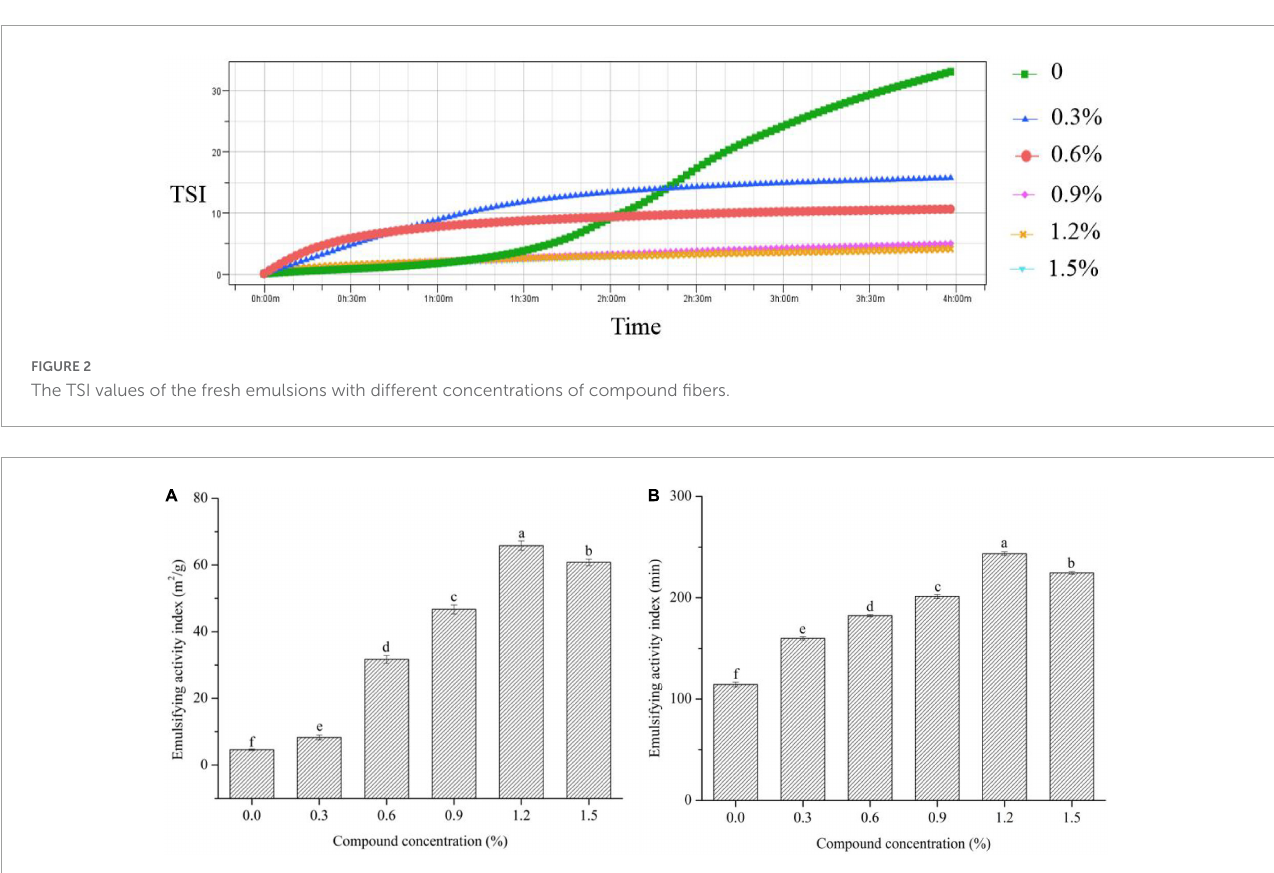
Frontiers in Nutrition